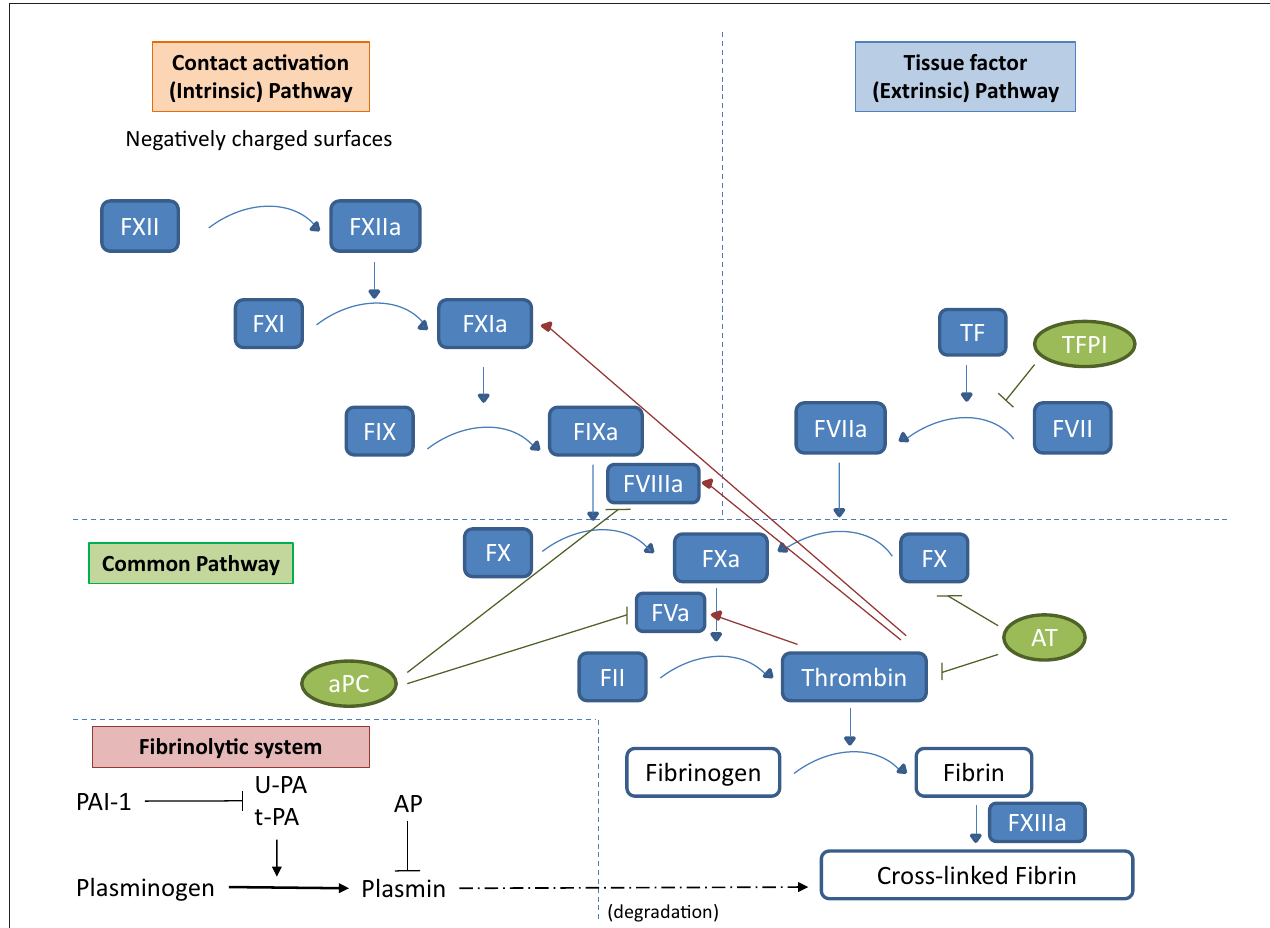
FIGURE 1 | Schematic representation of the coagulation cascade and the fibrinolytic system. In the coagulation cascade, the extrinsic pathway starts with tissue factor (TF) and activated factor VII (FVIIa). Tissue factor in physiological conditions is not in contact with the blood; however, damage of blood vessel structure can expose this membrane-associated glycoprotein to the blood, thus activating the extrinsic pathway of the coagulation cascade. TF can also be expressed by mononuclear cells or endothelial cells in response to inflammatory mediators. The TF/FVIIa complex promotes the activation of factor X (FXa). In the intrinsic pathway , negatively charged surfaces (such as phospholipids and polyphosphates from activated platelets) activate FXII, initiating a cascade leading to FXa. The common pathway FXa, along with the cofactor FVa, converts prothrombin (FII) to thrombin (FIIa). Finally, thrombin activates fibrinogen into fibrin and FXIIIa acts on fibrin strands to form a fibrin mesh. Regulation of coagulation activation occurs by three distinct natural anticoagulant pathways: AT (which blocks FXa and thrombin), TFPI (which inhibits the tissue factor–factor VIIa complex), and aPC (which proteolytically degrades factor Va and factor VIIIa). Natural regulators of the coagulation cascade are indicated in green: TFPI, AT, and aPC. Once the first thrombin is produced, it induces the propagation of the coagulation cascade (red arrows) but also a feedback regulation through aPC. In the fibrinolytic system, uPA and tPA catalyze the proteolysis of plasminogen into plasmin, which, in turn, degrades fibrin. Inhibition of the plasminogen system occurs by specific PAIs and by α 2-AP at the level of